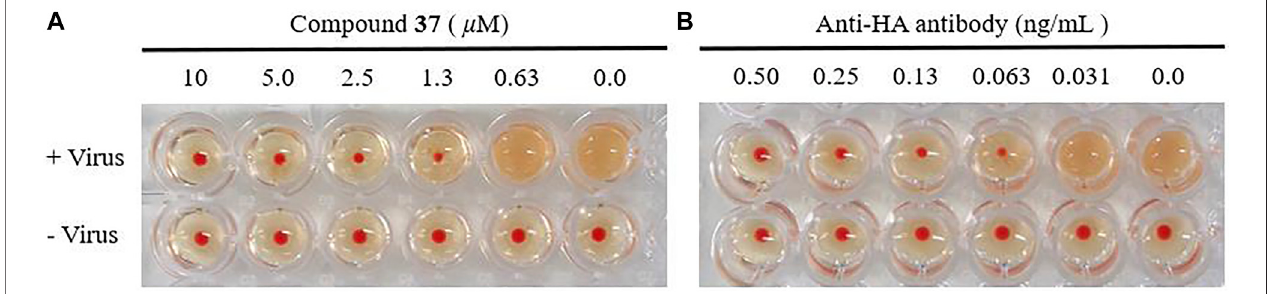
Frontiers in Chemistry |